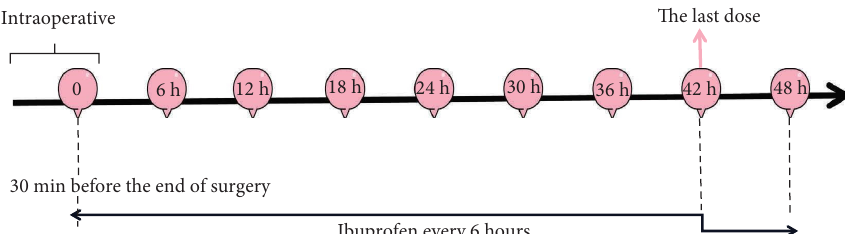
Figure 3: Study design.